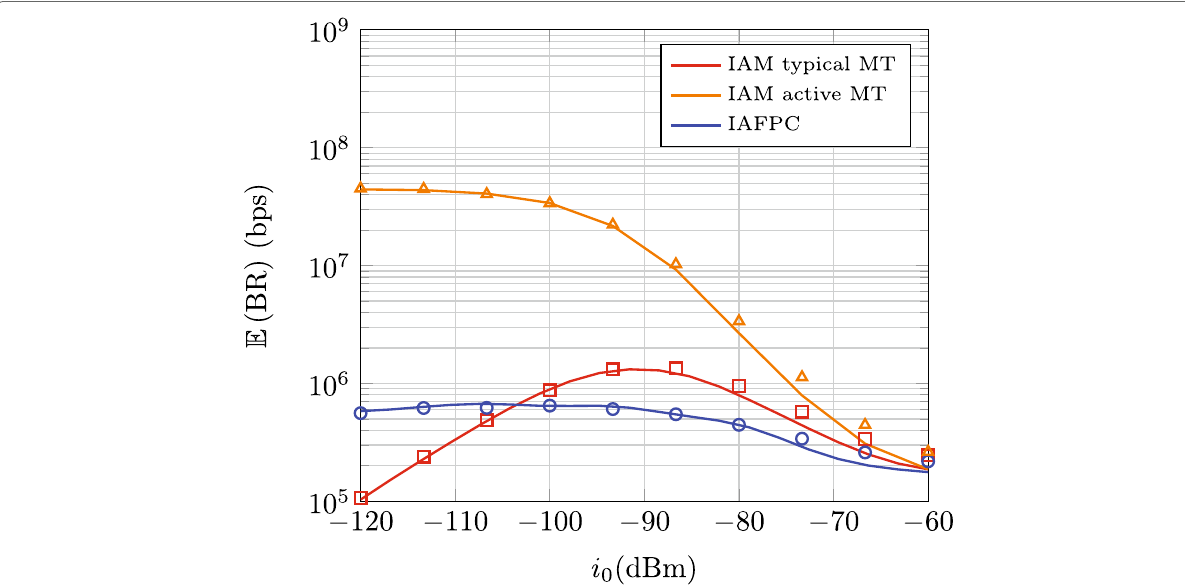
Fig. 8 Comparison of average BR of IAFPC and IAM for (cid:5) = 1, t ( 1 ) / t ( 2 ) = 9 dB, and p max → ∞ . As for IAM, two cases are considered: the typical MT and the typical active